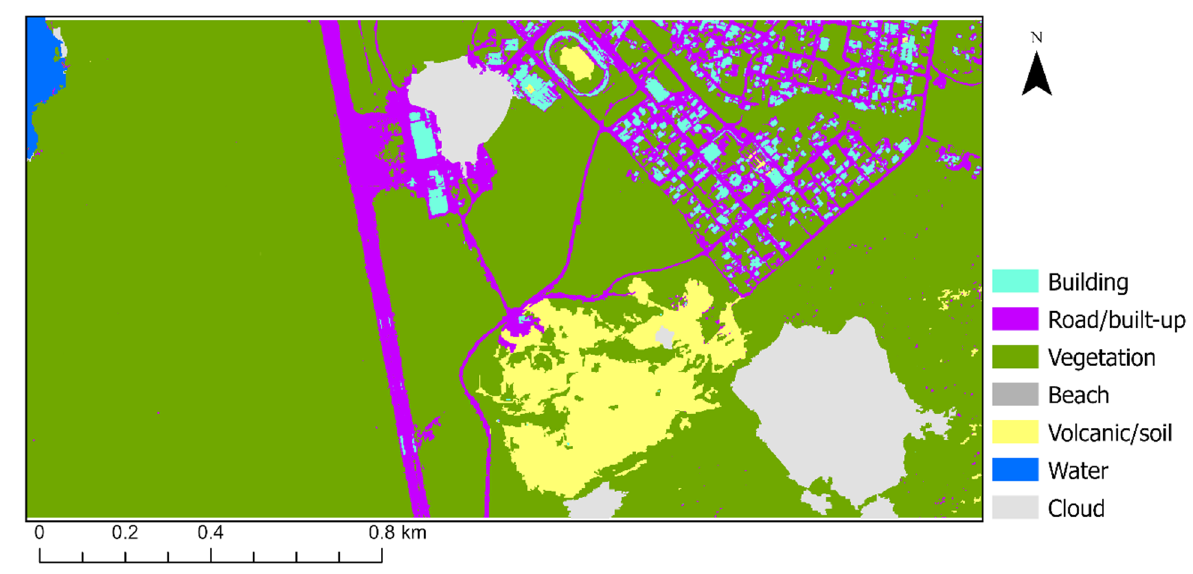
Figure 6. U-Net classification results using four spectral bands of a WorldView-2 image as input. Only testing image (southern portion of the study area) is presented to emphasize the U-Net’s generalization capability. Table 3. Error matrix for U-Net image classification was generated using reference data derived from visual interpretation of WorldView-2 image and the Google Earth’s very high-resolution imagery archive. A total of 90 points were randomly selected for the accuracy assessment. UA and PA denote user’s and producer’s accuracy, respectively.